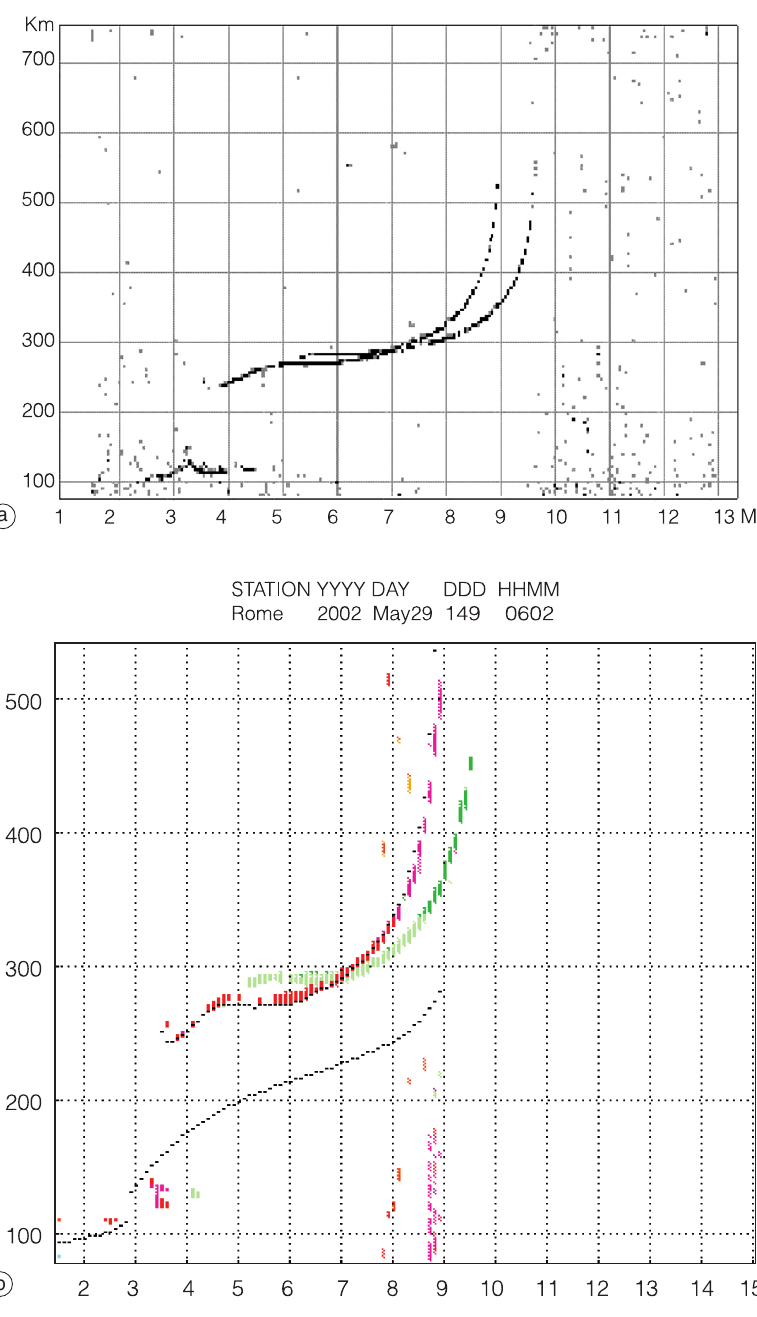
Fig. 4a,b. Ionograms recorded at 7 a.m. 2002/5/29: a) AIS-INGV ionosonde; b) other digital